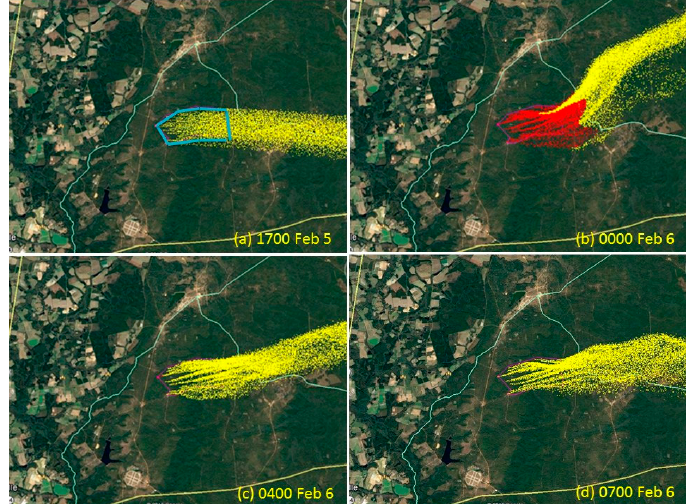
Figure 8 . PB-P simulation of smoke during night of 5 February 2011 at four times ( a – d ). Yellow indicates smoke particles. Red indicates formation of fog. The blue / pink area is the hypothetical burn site of Block 3.